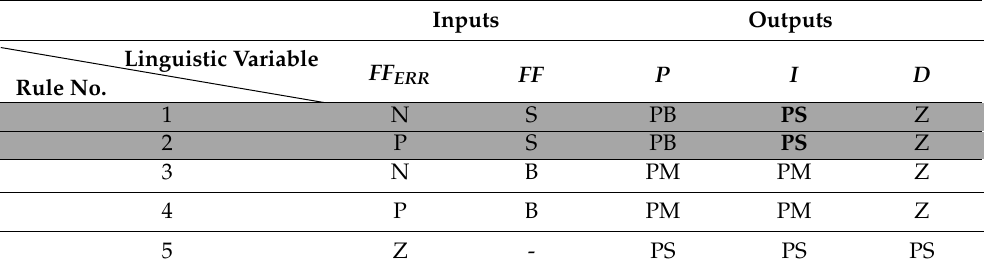
Table 4. The modified rule base of the adaptive fuzzy PID